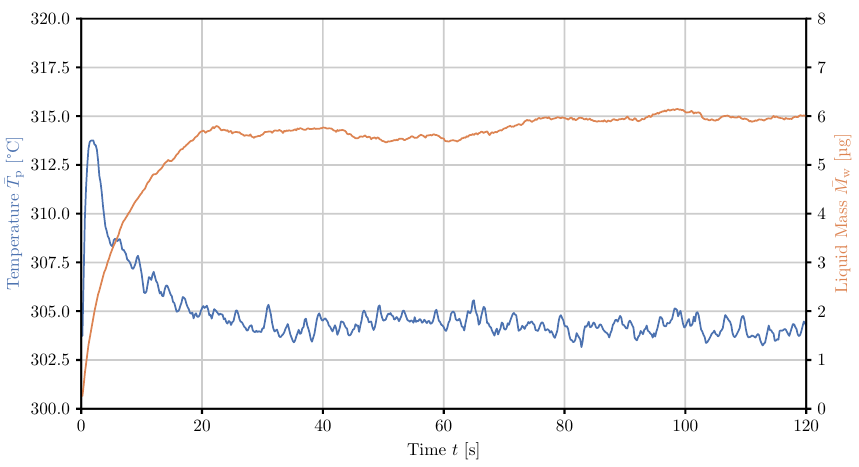
Figure 8. Mean particle temperature and mean particle surface liquid over time in case 3 of Orth et al. [18], with a fluidization gas velocity of ˙ V air = 80Nm 3 h − 1 and temperature of T air,in = 50°C, a spray rate of ˙ M spray = 20g min − 1 , an atomization pressure of p spray = 0.5bar and a spray air temperature of